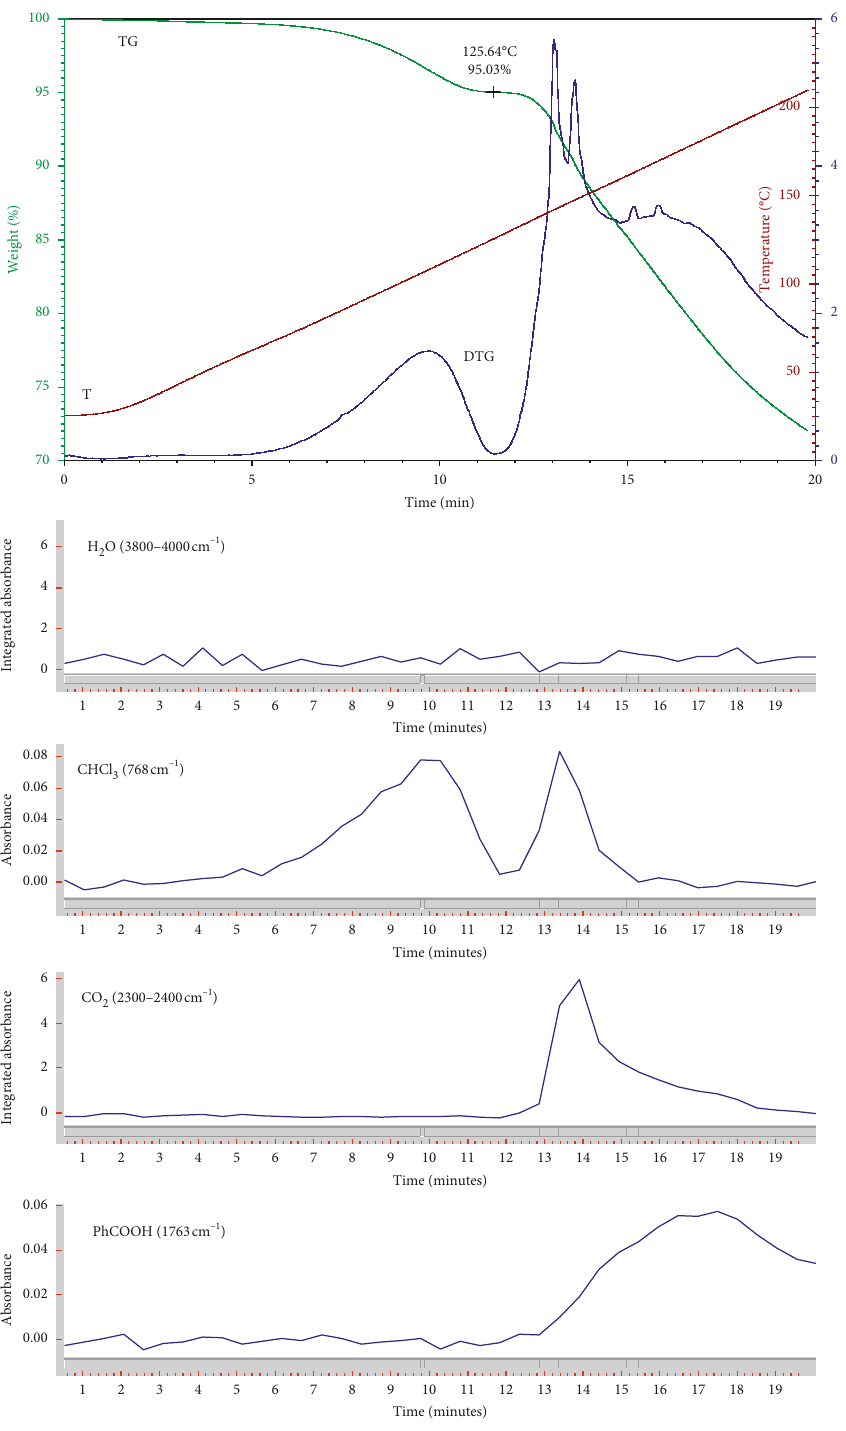
Figure 2: Results of a TG-FTIR run of the diastereomeric salt during dynamic